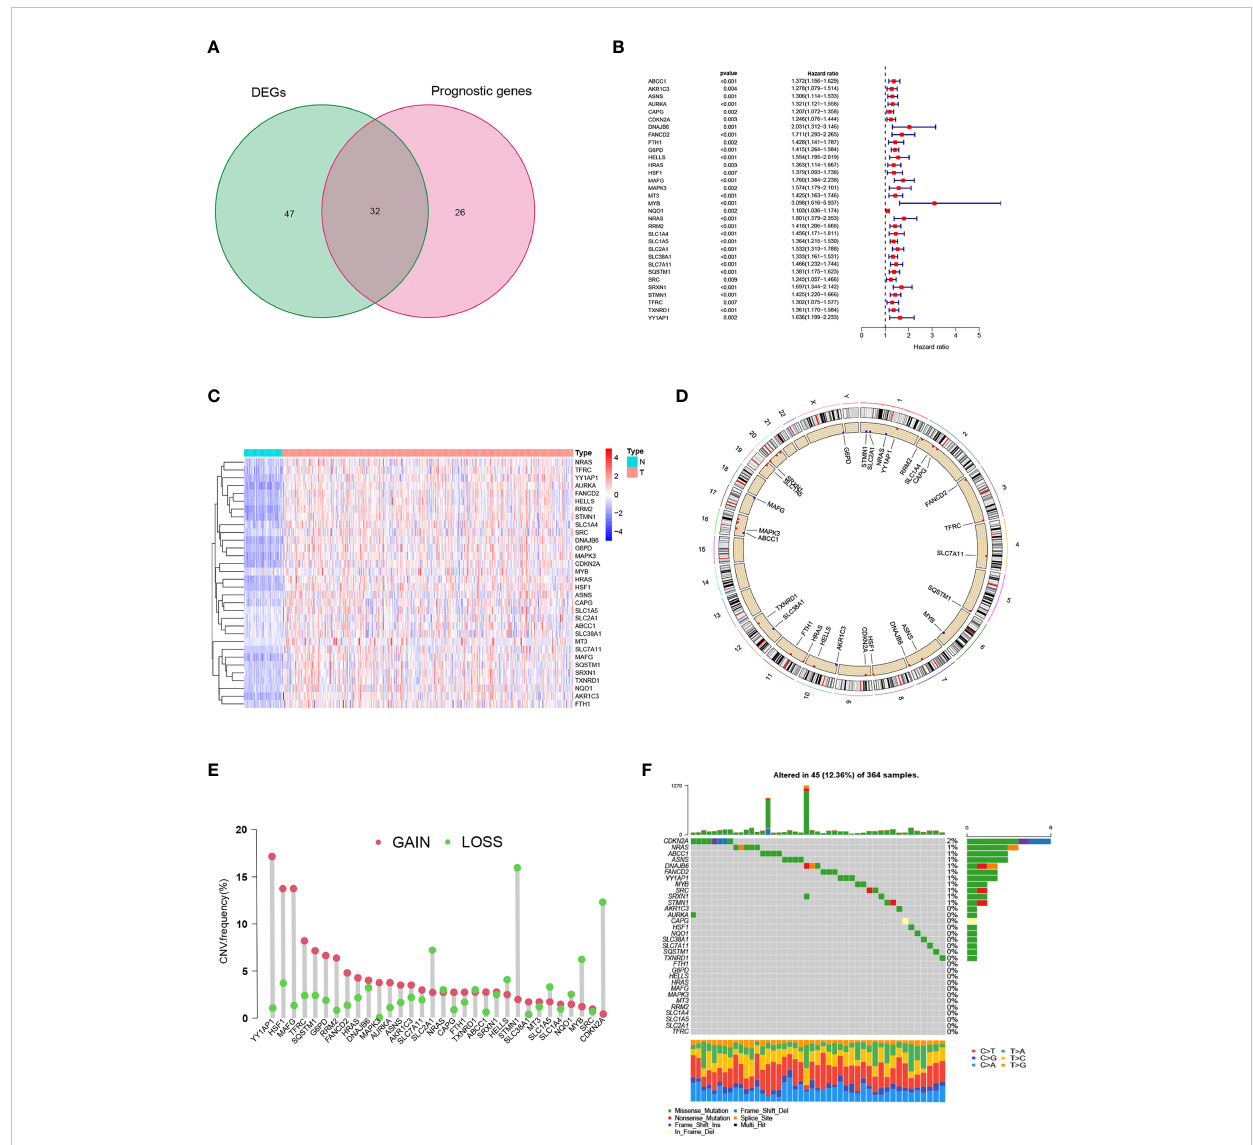
FIGURE 1 Prognostic ferroptosis-related gene (FRGs) differentially expressed in TCGA. (A) Venn graph showing the intersection of prognostic genes and differentially expressed genes. (B) Forest plots illustrating the Univariate Cox regression analysis of overlapping genes. (C) Expression of overlapping genes in tumor tissue. (D) CNV alteration locations for 32 FRGs. (E) The frequency of CNV variation of 32 FRGs. Alteration frequency was represented by the height of the column. Green dots indicating deletions; red dots indicating ampli fi cations. (F) The mutation frequency of 32 FRGs in 364 patients with HCC. One patient was represented by each column. The upper bar plot indicated the extent of tumor mutations. Numbers on the right indicated the frequency of mutations in each gene. The right bar plot showed the proportions of the different types of variants. Stacked bar plot of each sample was able to show the fraction of